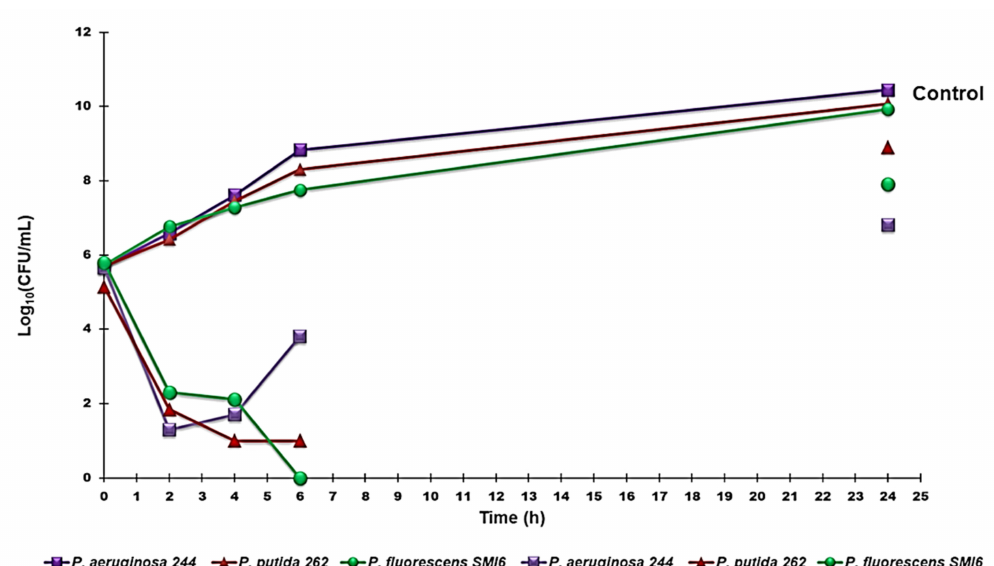
Figure 5. Time-killing curves performed with G5-PDK (at concentrations equal to 4 × MIC) on P. aeruginosa 244, P. fluorescens SMI6, and P. putida